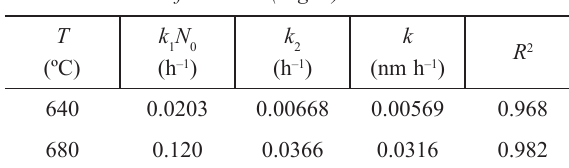
Fig. 5 – Points represent transformation experimental data from anatase to rutile 27 , and curves are fitted with Eq. (9)